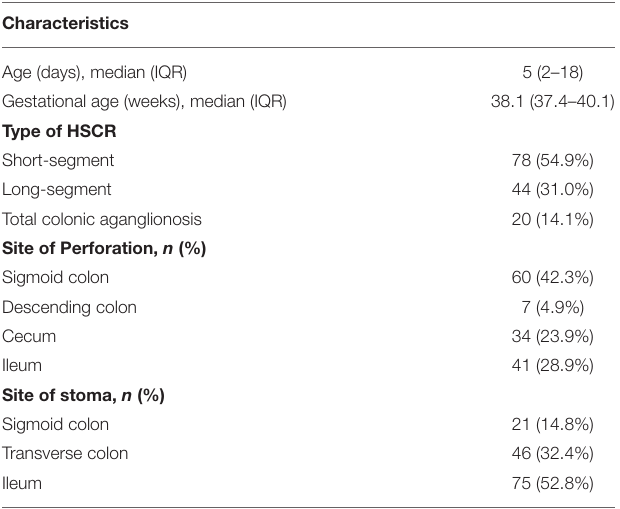
TABLE 1 | Demographic and outcome data in neonates with perforated HD ( n = 42).